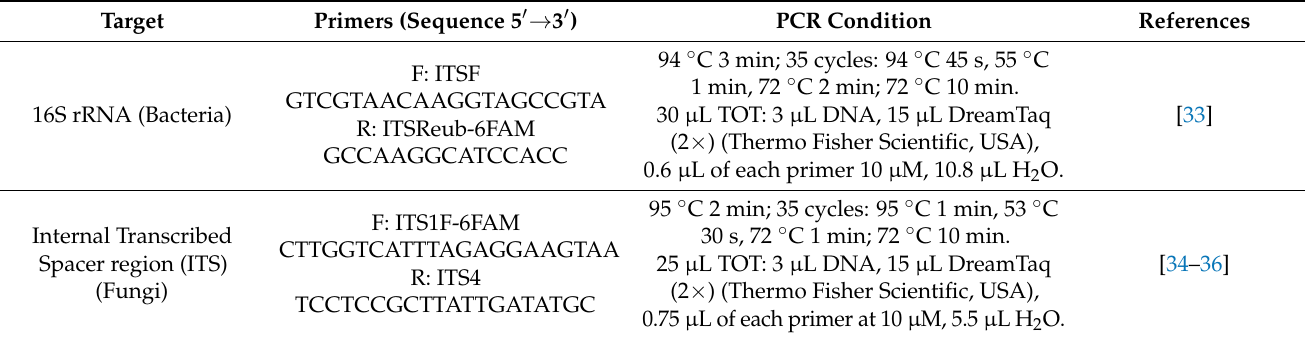
Table A1. PCR condition for ARISA